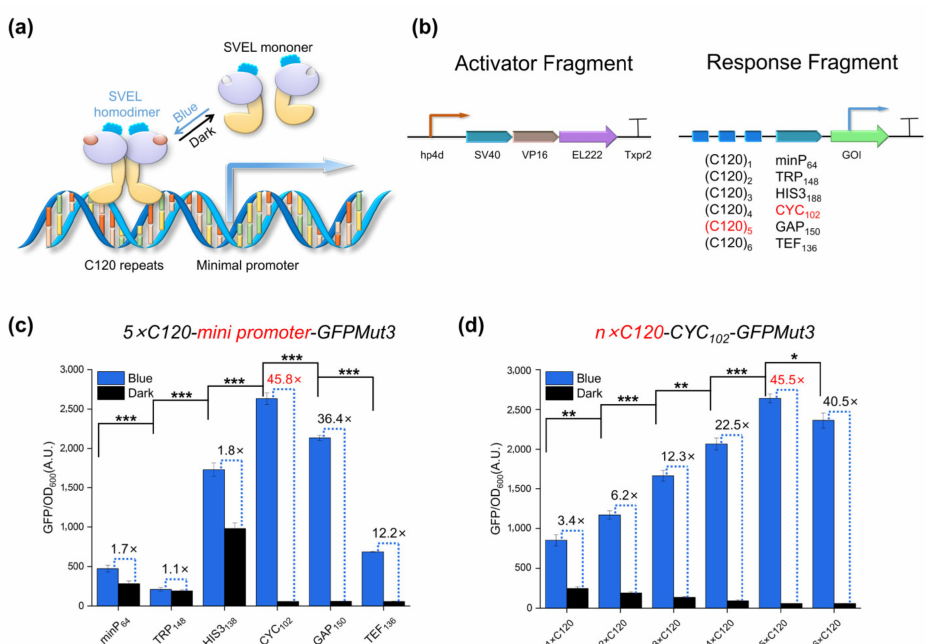
Figure 1. Design, optimization and validation of the single-component optogenetic system. ( a ) Blue light induction mechanism of EL222. ( b ) Configuration of the single-component light-switchable gene expression system. ( c , d ) Fine tuning pYLBI system by altering the promoter configurations, including different minimal promoters ( c ) and the C120 copy number from 1 to 6 ( d ). Unless otherwise stated, error bars indicate Means ± S.D. (n = 3); Significance of differences between all blue induced states: * p < 0.05, ** p < 0.01, *** p <